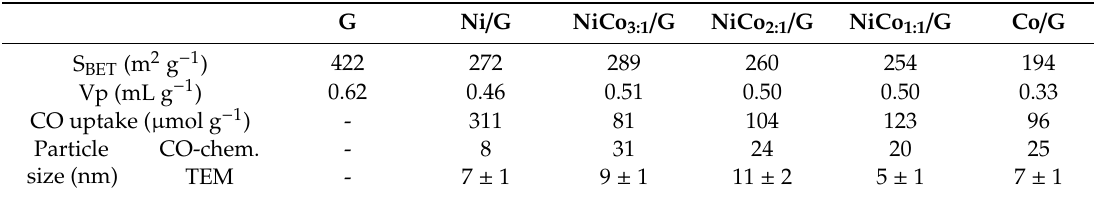
Table 1. Physico-chemical properties of the resulting catalysts.